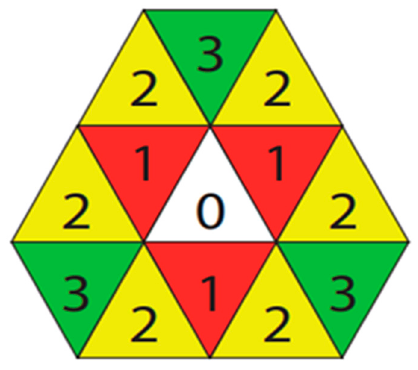
Figure 2. Three types of neighbors of trixel 0. 1-neighbors are red, 2-neighbors are yellow and 3-neighbors are green.